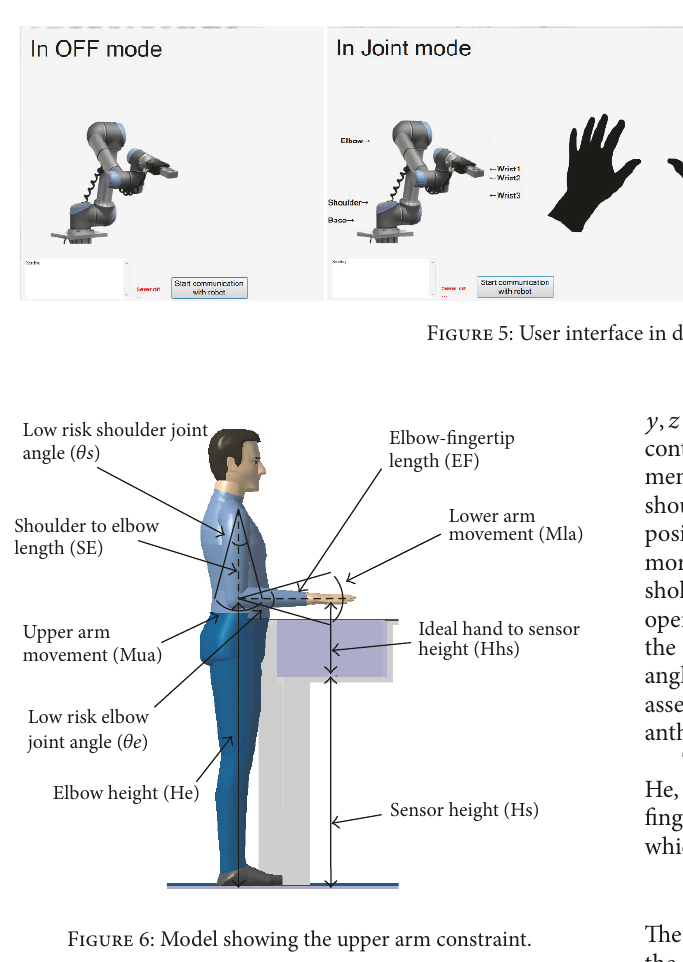
Figure 6: Model showing the upper arm